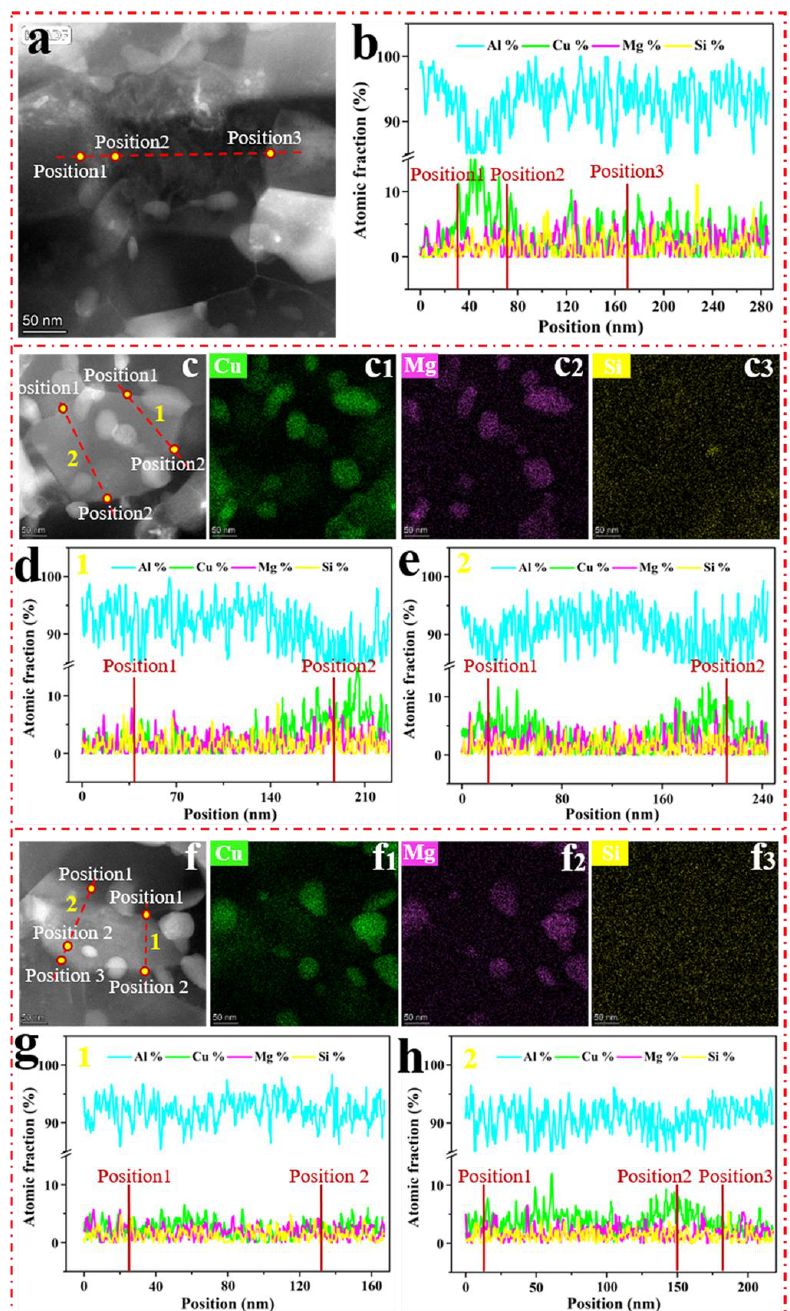
Figure 7. HAADF-STEM images of the grain boundaries with SMGT alloy under 210 °C aging for different times: ( a ) 6 min, ( c ) 27 min, and ( f ) 60 min. EDS elemental mappings are shown in ( c 1 – c 3 ) and ( f 1 – f 3 ) of ( c ) and ( f ), respectively. The HAADF-STEM images show lines across the grain boundary ( a , c , f ). The corresponding EDS line scan curves are displayed in ( b ), ( d,e ) and ( g,h ) of ( a ), ( c ) and ( f ), respectively.